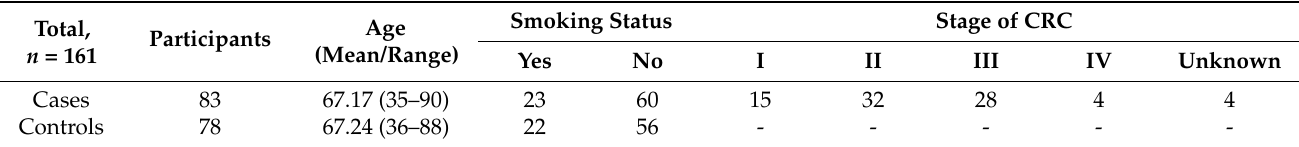
Table 1. Characteristics of female CRC cases and